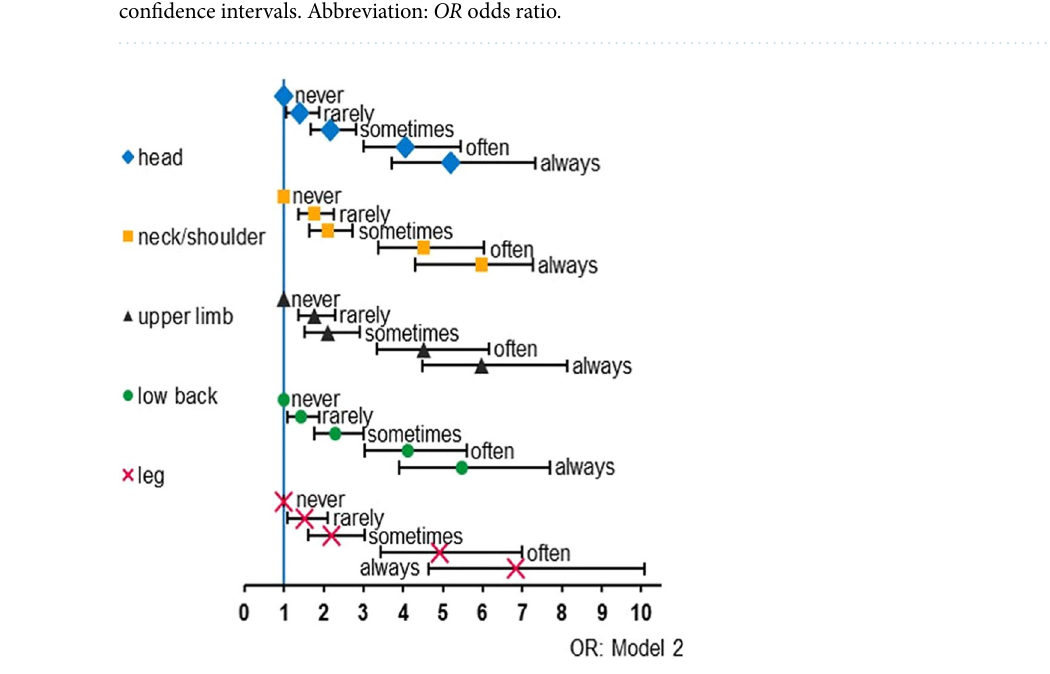
Figure 4. Frequency of feelings of social isolation and pain symptoms developed during the COVID-19 pandemic. Odds ratios of each pain symptom in model 2 according to the frequency of feelings of social isolation compared to never felt feelings of social isolation were indicated. X-axis indicated odds ratio. Bars indicated 95% confidence intervals. Abbreviation: OR odds